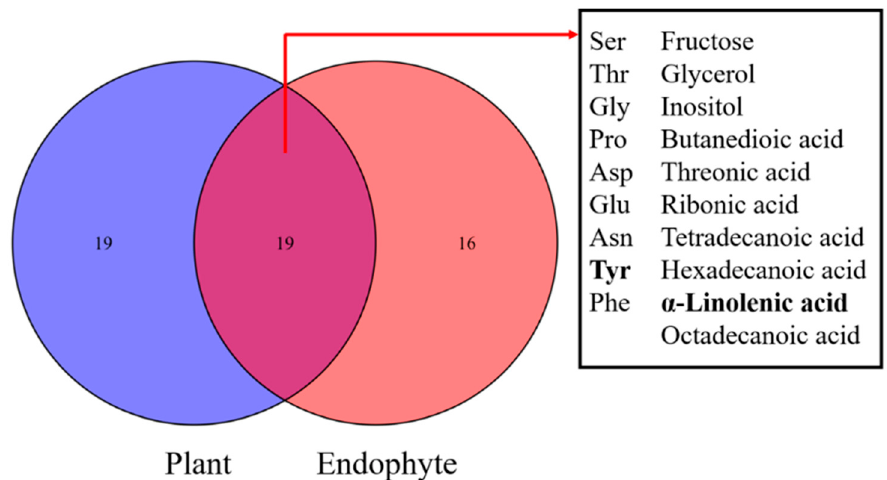
Figure 7. Venn diagram of the metabolite distribution in Epichloë endophytes and A. sibiricum. Metabolites present in both endophytes and A. sibiricum are listed, in which the metabolites with bold font are not only the differential metabolites of Eg and Es but also the differential metabolites of A. sibiricum infected with Eg and Es.